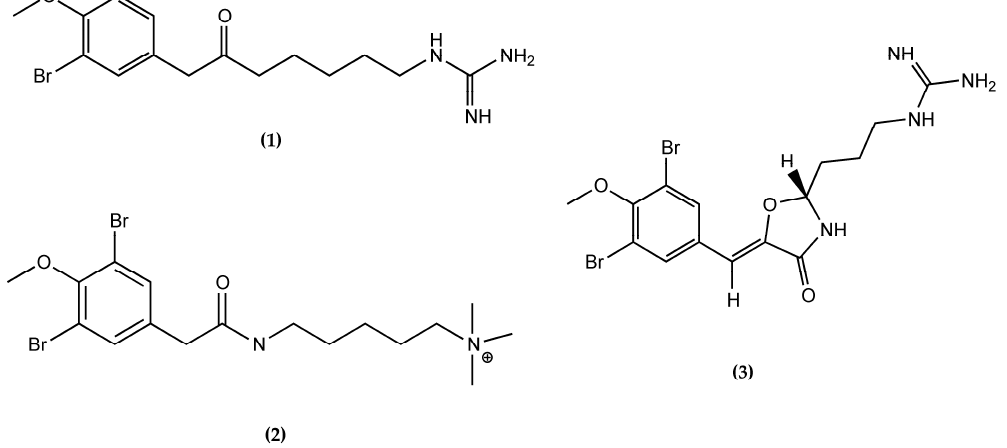
Figure 3. The structurally related compounds Securidine A ( 1 ), Pulmonarin ( 2 ), and Synoxazolidinone B ( 3 ).